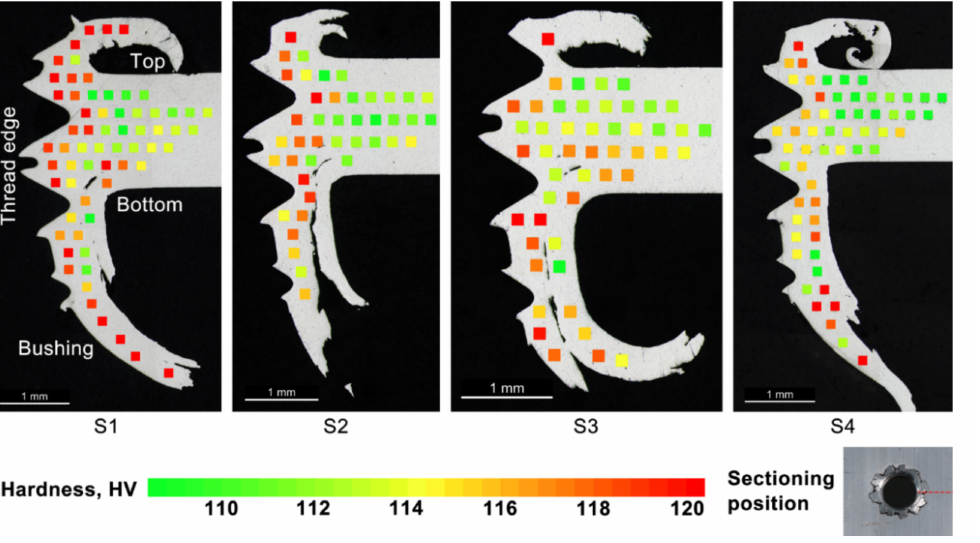
Figure 7. Hardness maps of the indentation points in the mid-sections of the threaded holes of S1 to S4. The sectioning position was indicated by the dashed line in the bottom right